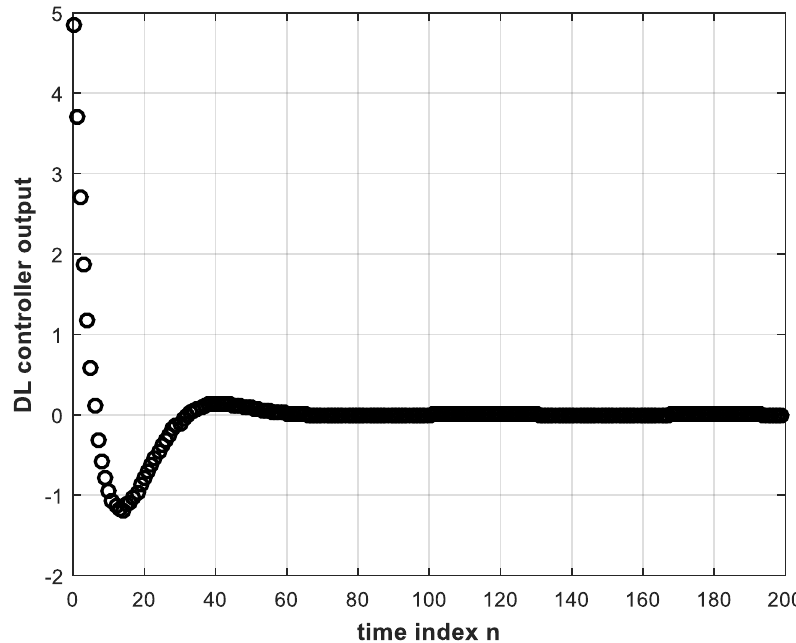
Figure 6. Output signal of trained DL controller (with two hidden layers) in inference mode.